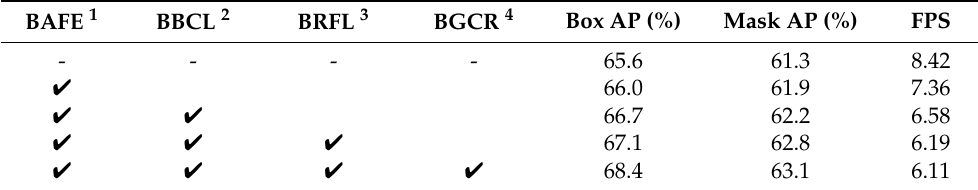
Table 5. Quantitative Results Component Analysis in GCIM-Block. Table 7. Quantitative Results Component Analysis in BABP-Block. BAFE